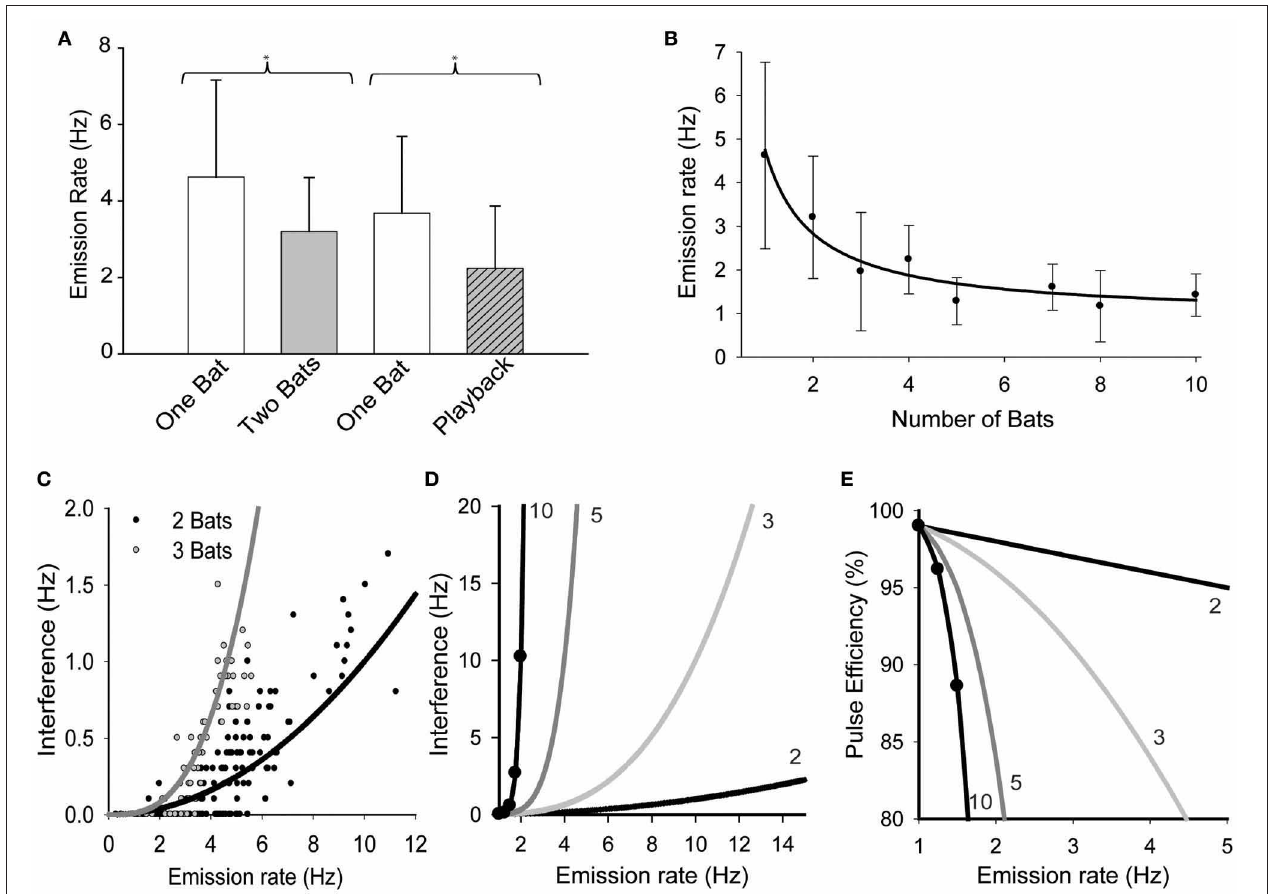
FIGURE 1 | The effect of group size on pulse emission rates. at which overlaps occurred (interferences) for pairs ( n = 141) and triads (A) Bats’ mean pulse emission rates recorded alone vs. when ( n = 56) of bats. Both sets of data were well fit by the same simple echolocating in pairs, and then again for alone vs. while echolocating power function of the form y = r τ n , where r = mean emission rate (Hz), τ = overlap window duration (ms) and n = number of bats. with a speaker simulating the presence of another bat echolocating [ r 2 = 0 . 71, F ( 1 , 140 ) = 344 . 9, P < 0 . 001]. Extending the functions derived (playback). (B) Average emission rates per bat plotted vs. the total from (C,D) illustrates the expected effect of pulse emission rates on number of bats in the group. Pairwise multiple comparisons indicated mutual interference rates for groups of 2, 3, 5, and 10 bats. (E) These that mean pulse emission rates for groups of 3 or more bats were functions were then used to predict the effect of pulse emission rates significantly lower than solitary bat emission rates ( Q = 5 . 033, on the proportion of pulses expected to generate unambiguous echoes, p < 0 . 05). Data were fit with a first order linear regression (cid:2) (cid:3) or y = 1 − r τ n (pulse efficiency) for different group solidline , y = 0 . 92 + 3 . 82 / x . (C) Plot of mean pulse rates vs. the rate